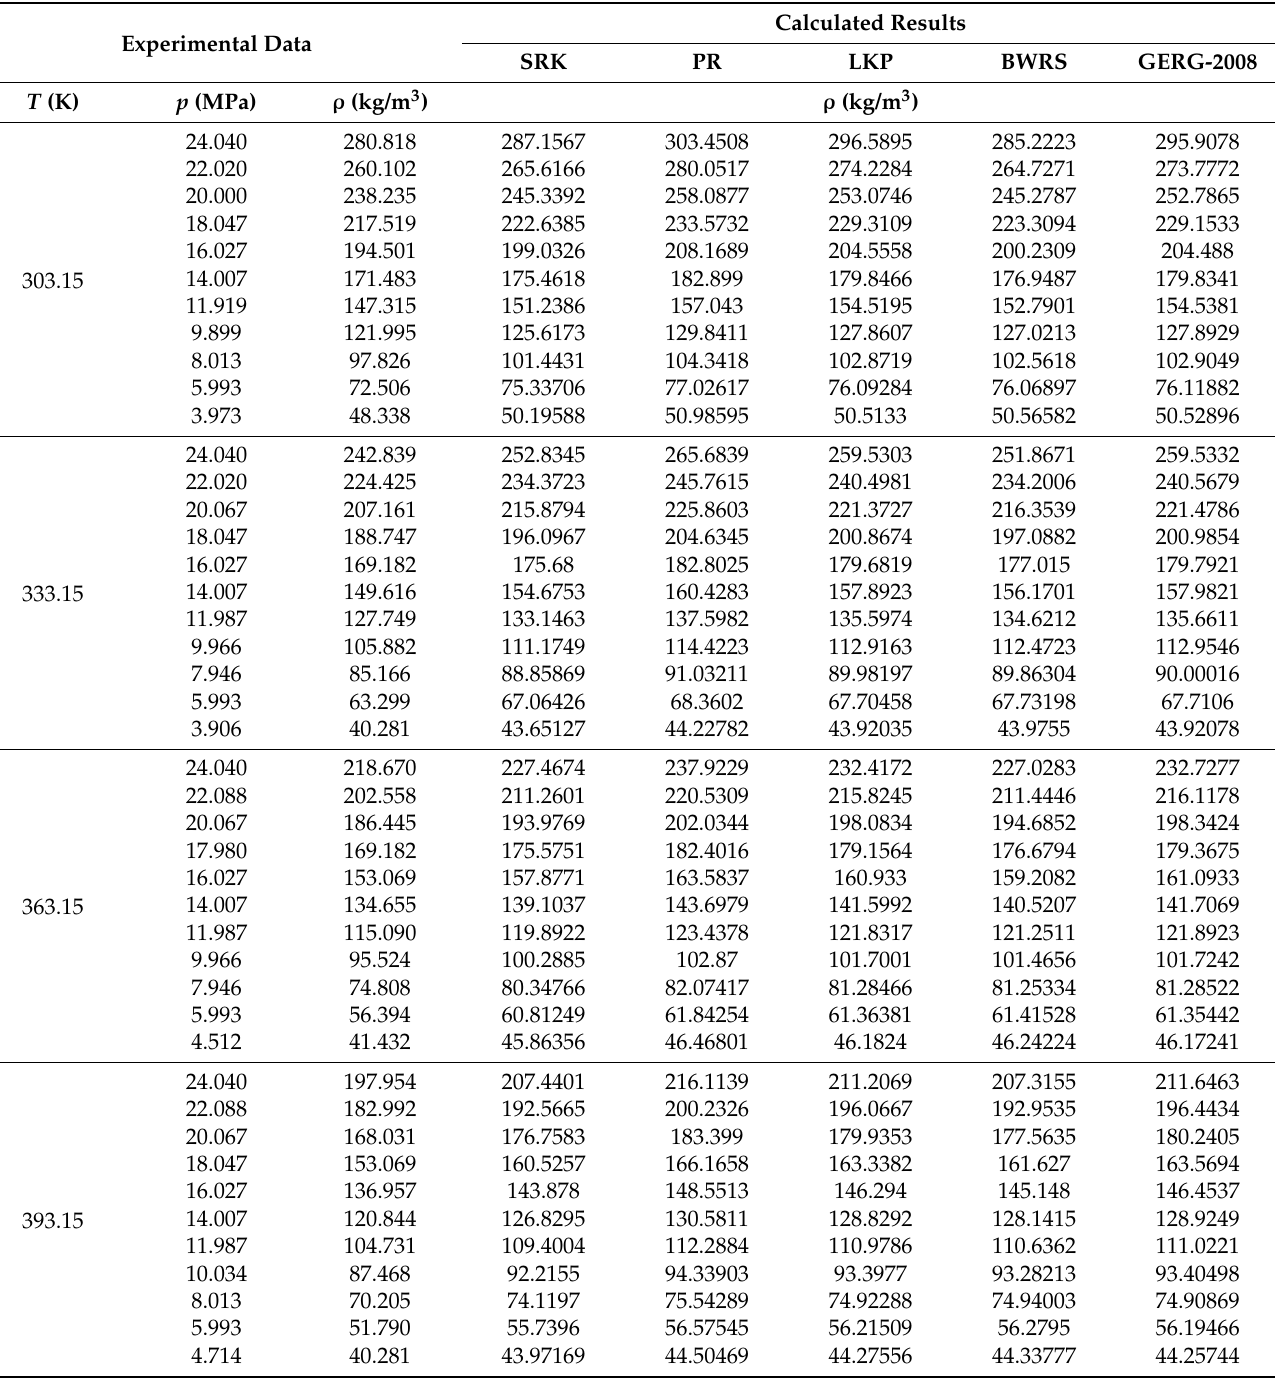
Table 4. Experimental data and calculated results of the gas density for Sample